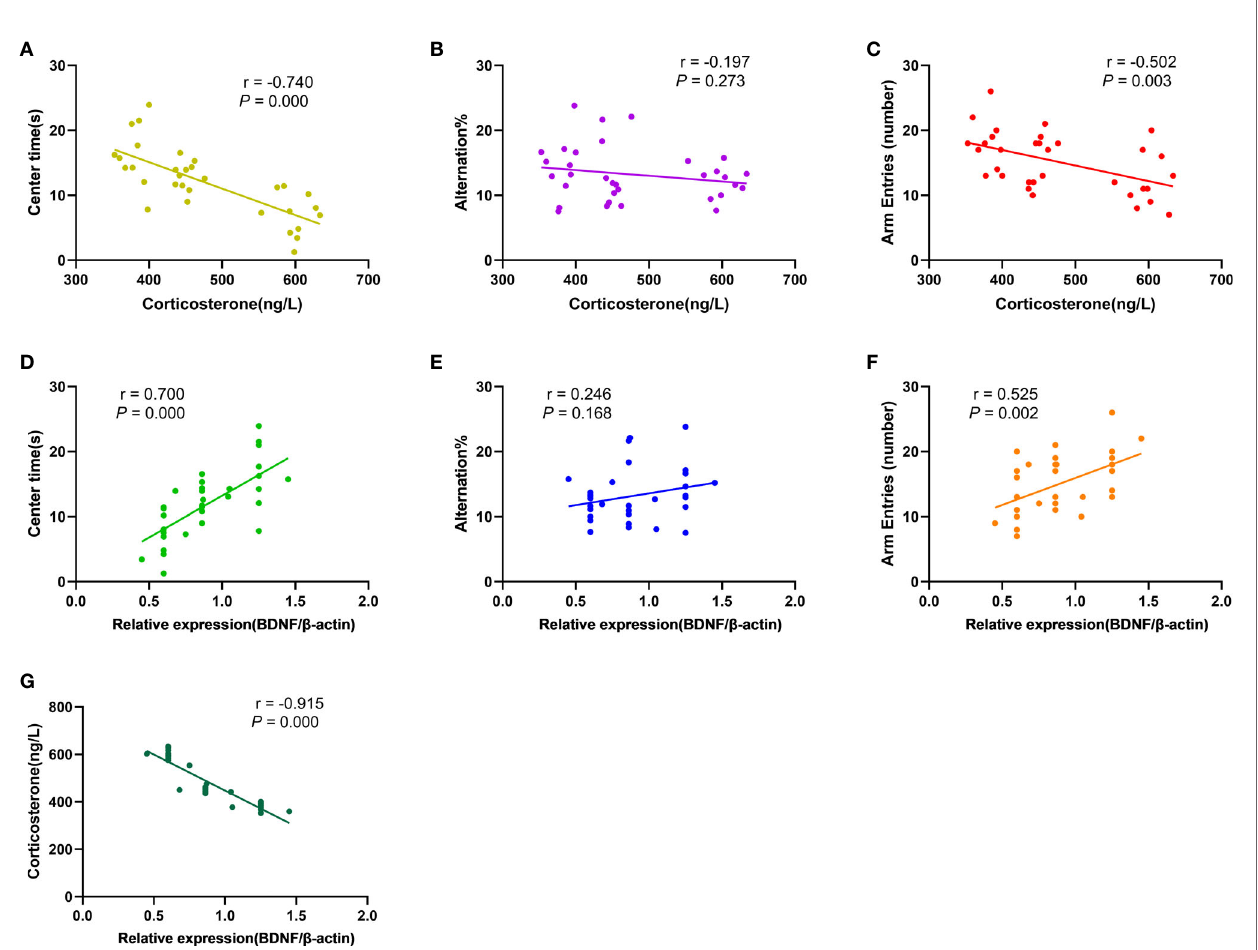
FIGURE 7 | Results of correlation analysis. (A) : The correlation between plasma CORT levels and time spent in the central area of rats in OFT (r= -0.740, p= 0.000); (B) : The correlation between plasma CORT levels and alternation % in Y-maze test (r= -0.197, P= 0.273); (C) : The correlation between plasma CORT levels and number of arm entries of rats in Y-maze test (r= -0.502, p= 0.003); (D) : The correlation between BDNF protein expression in the PFC and time spent in the central area of rats in OFT (r= 0.700, p= 0.000); (E) : The correlation between BDNF protein expression in the PFC and alternation % in Y-maze test (r= 0.246, p= 0.168); (F) : The correlation between BDNF protein expression in the PFC and number of arm entries of rats in Y-maze test (r= 0.525, p= 0.002); (G): The correlation between BDNF protein expression in the PFC and plasma CORT levels (r= -0.915, P=